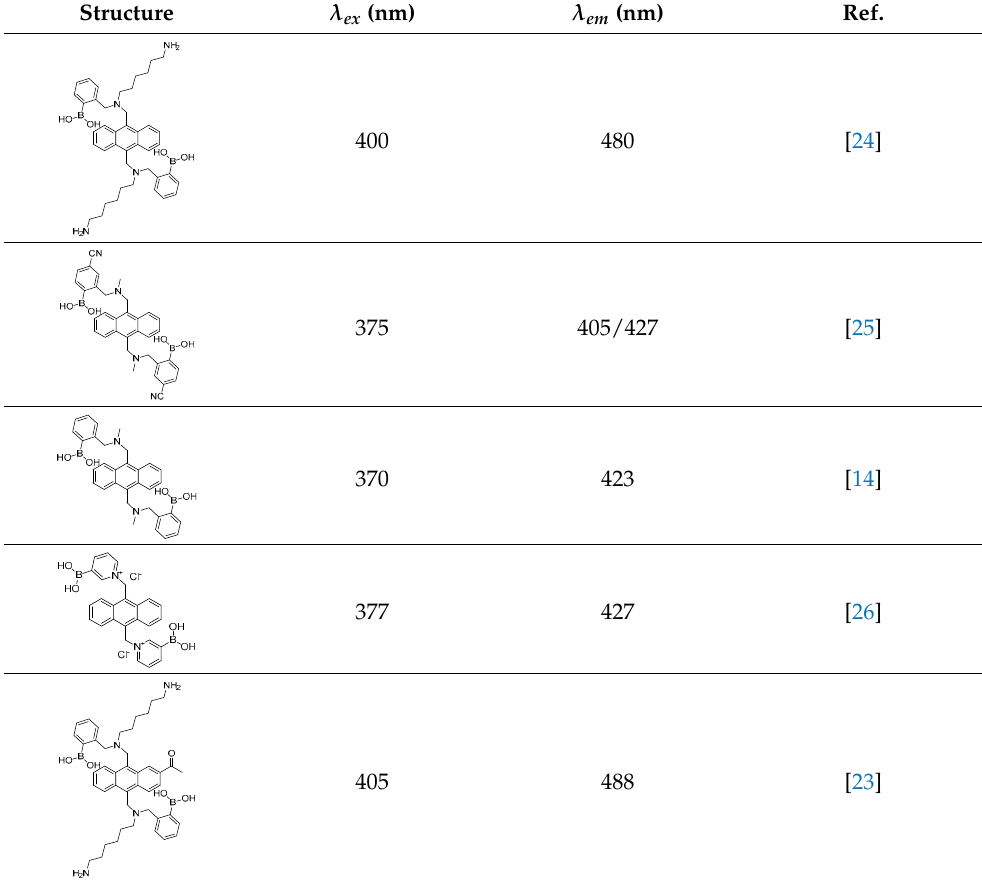
Figure 1. Emission (Em. ) and excitation (Ex.) spectra of trifluoromethyl diboronic anthracenes ( a ) with and ( b ) without an acetyl group. Norm. I. denotes normalized emission and excitation intensity at the maximum wavelength. Table 1. Emission and excitation wavelength of the reported derivate of diboronic acid anthracene. Structure Ref.